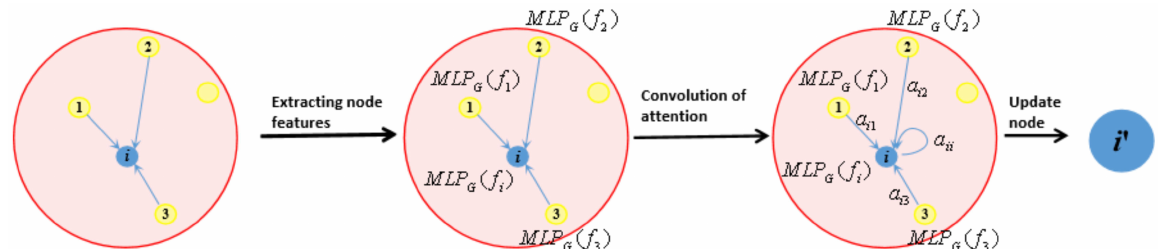
Figure 2. An illustration of the graph attention convolution process by the central node i and its neighborhood. We randomly select n points ( n = 4 in the Figure, including itself), within the radius R of the center node, as the target nodes to calculate the feature of the node i . The attention mechanism is used to express the degree of association between the central node and the neighboring nodes in local feature